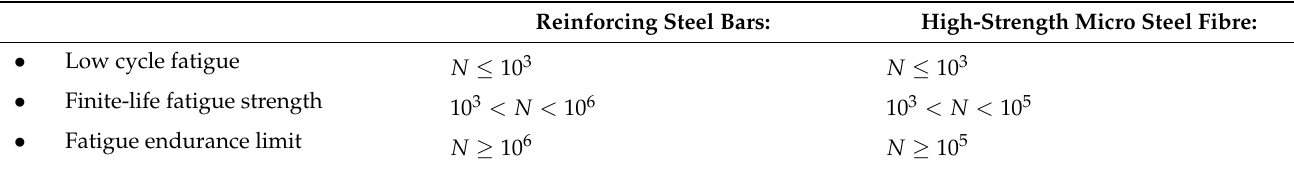
Table 4. Modified ranges of fatigue life for high-strength micro steel fibres. Reinforcing Steel Bars: High-Strength Micro Steel